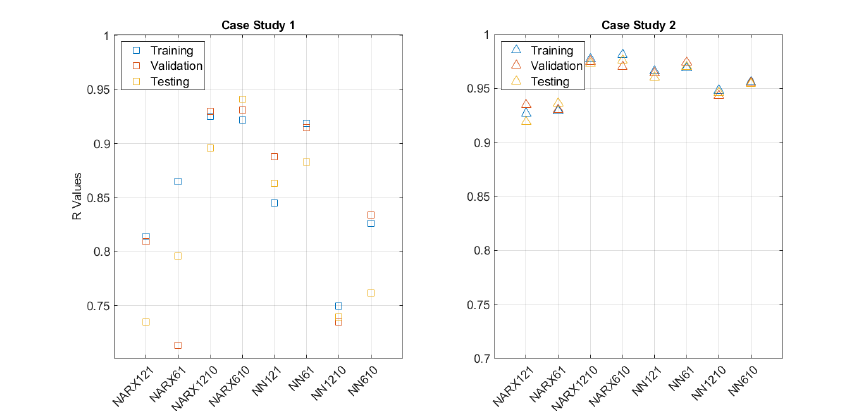
Figure 2. Comparison of the R-values for both cases investigated in this paper, during training.